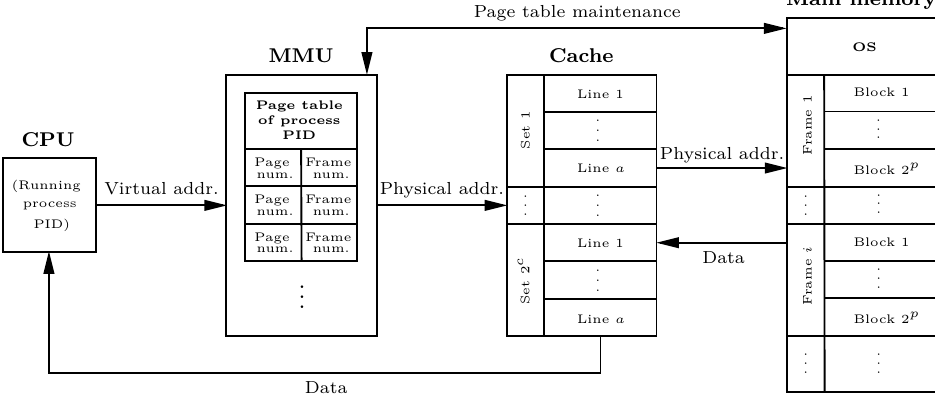
Figure 1: Components involved in the memory management of conventional modern computer systems [And19].